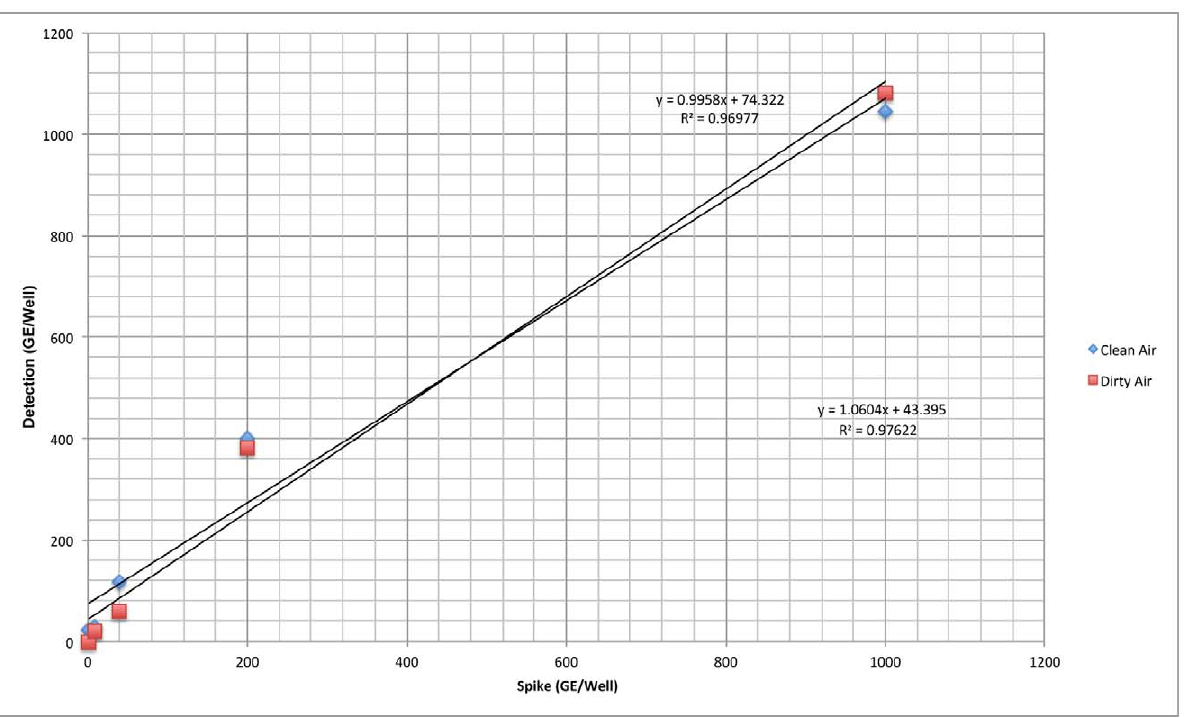
Figure 2. Linearity of response of the biothreat assay. B. anthracis DNA was spiked into AE buffer (Clean) or an extract from an environmental air filter (Dirty) at concentrations ranging from 0–1000 GE/well. The reported response from the PLEX-ID system was linear over the entire concentration range tested in both cases. doi:10.1371/journal.pone.0036528.g002 PCR reaction every 30 seconds in a fully automated modality. The